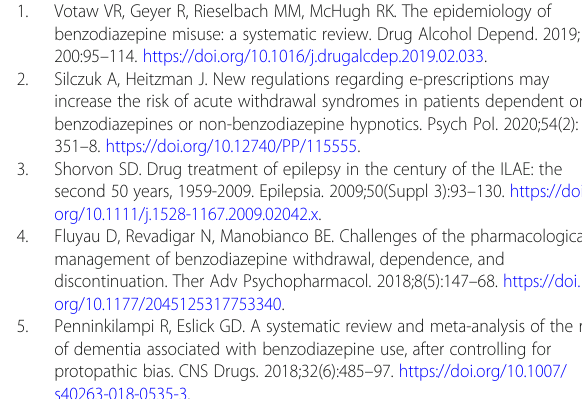
Additional file 1. Diagram 1: Diazepam substitution vs. elimination and seizure